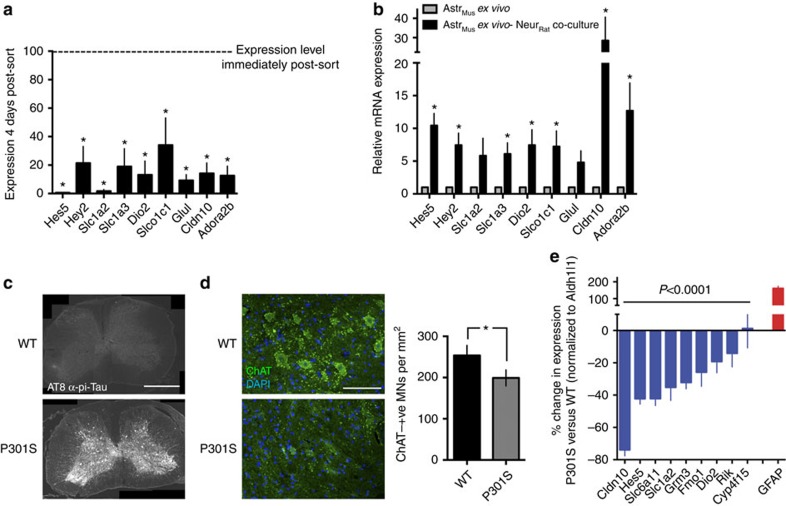
Neuron-induced astrocytic gene expression is reversible and disrupted in neurodegenerative disease.(a) Mouse astrocytes were isolated by immunopanning (using an anti-GLAST antibody) at P7. Expression of the indicated neuron-induced astrocytic genes was measured both immediately post-isolation and after 4 days of ex vivo maintenance (neuron-free). *P<0.05 unpaired t-test, (n=5). (b) Mouse astrocytes isolated as in a, and maintained for 22 days in culture, with (black) or without (grey) the last 11 days being in the presence of rat neurons. *P<0.05 unpaired t-test, (n=7). (c) Example micrographs showing phospho-tau immunoreactivity in spinal cord sections of the Thy1-P301S transgenic mouse (at week 20). Scale bar, 500 μm. (d) (Left) Example micrographs showing loss of ChAT-positive motor neurons in spinal cord sections of the Thy1-P301S transgenic mouse at week 20. Scale bar, 50 μm. (Right) Quantitation of loss of ChAT-positive motor neurons in spinal cord sections of the Thy1-P301S transgenic mouse. *P<0.05 unpaired t-test, (n=5 animals of both genotypes). (e) Expression of the indicated astrocyte-specific, neuron-induced genes in the spinal cord of week 20 wild type (WT) and P301S mice, normalized to astrocyte-specific gene Aldh1l1. Rik: 2900052N01Rik. P<0.0001, two-way analysis of variance, P value indicates main effect of genotype (n=6 animals of both genotypes). All error bars represent s.e.m.